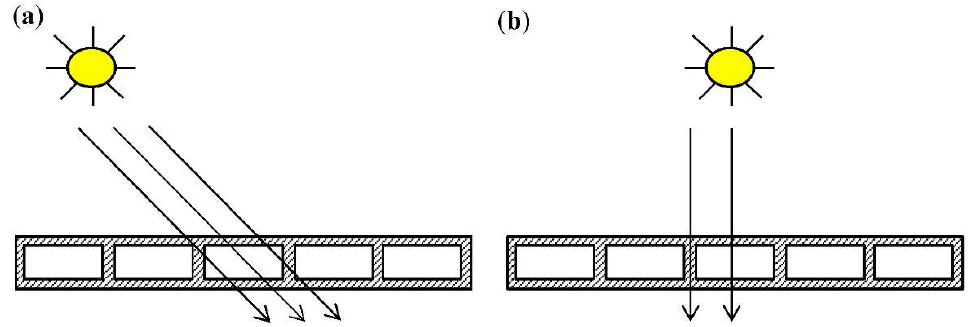
Figure 3. Position of the enclosure to the Sun—effect of solar azimuth: ( a ) the solar rays are tilted to cover; ( b ) the solar rays are perpendicular to cover.